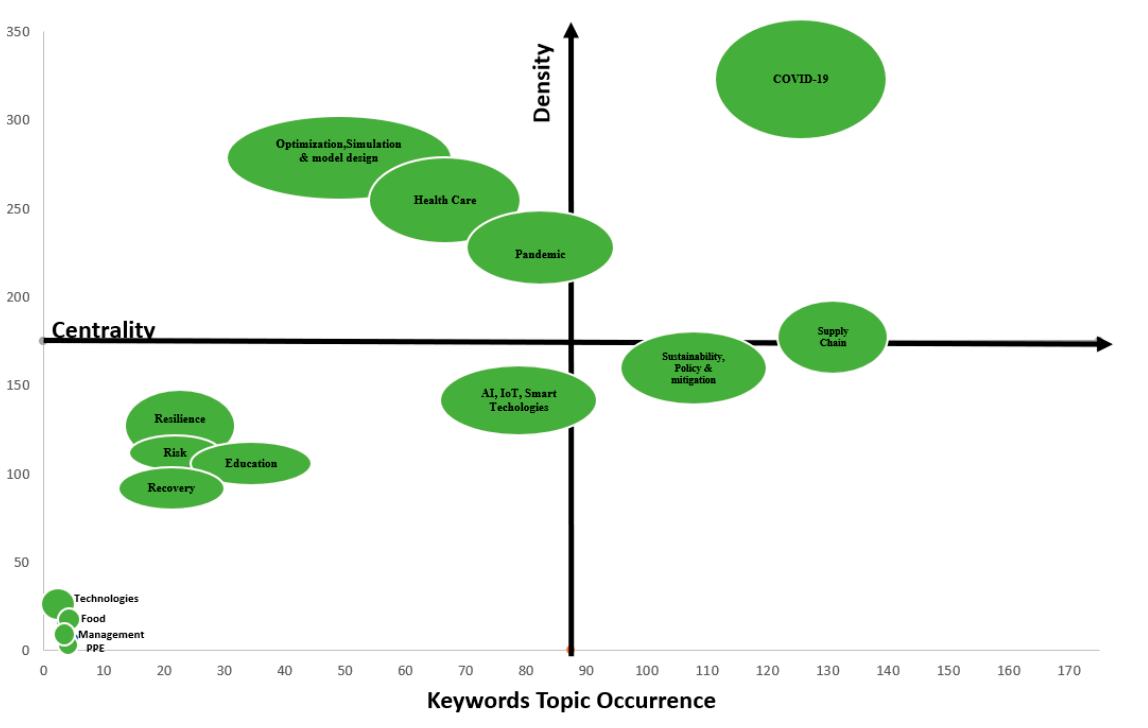
Figure 9. Articles’ Keyword Network Centrality and Density Analysis.